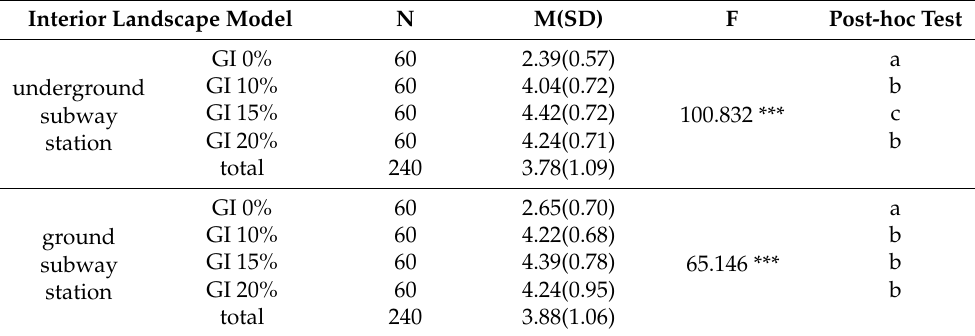
Table 8. Attention Restoration Effect of Interior Landscape Models in Subway According to